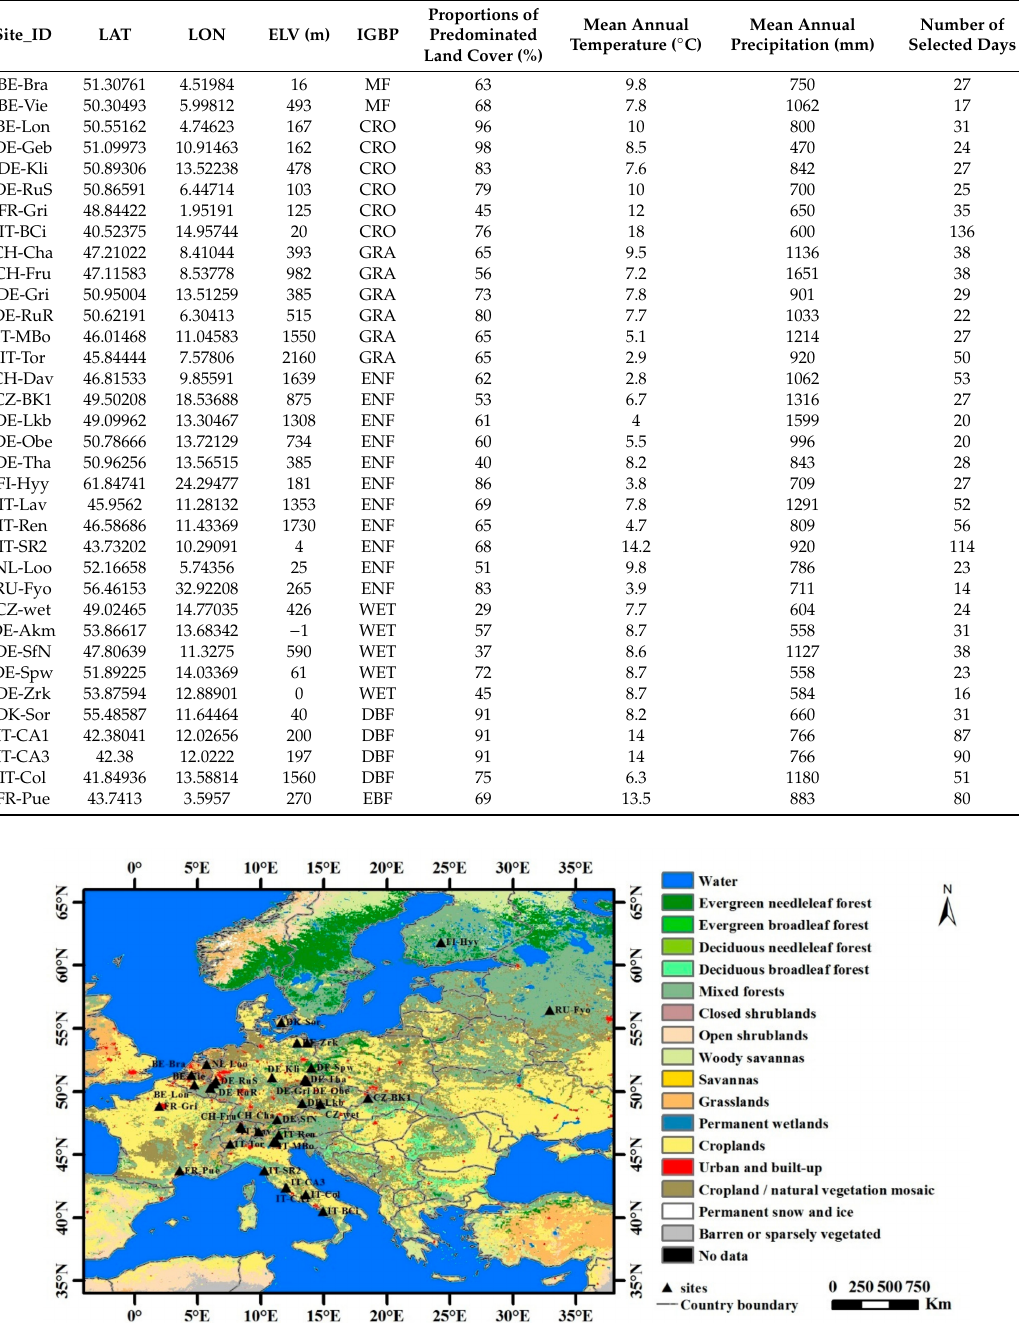
Figure 2. Location of FLUXNET2015 sites used in this study (land cover from MCD12C1 product in